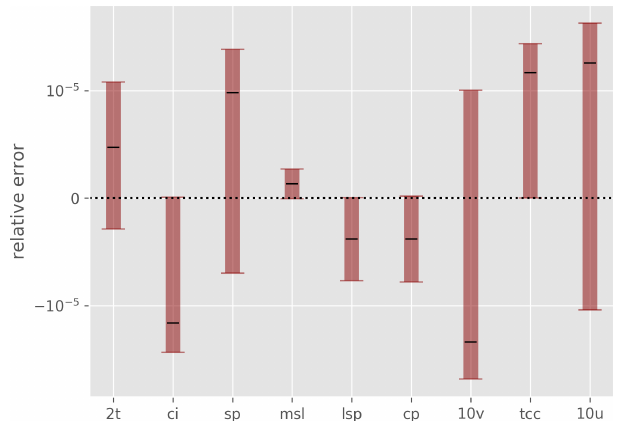
Figure 9. Maximal relative errors (over grid points and time steps) for a few surface fields. The error bars denote the error on the GRIB values obtained by evaluating Eq.